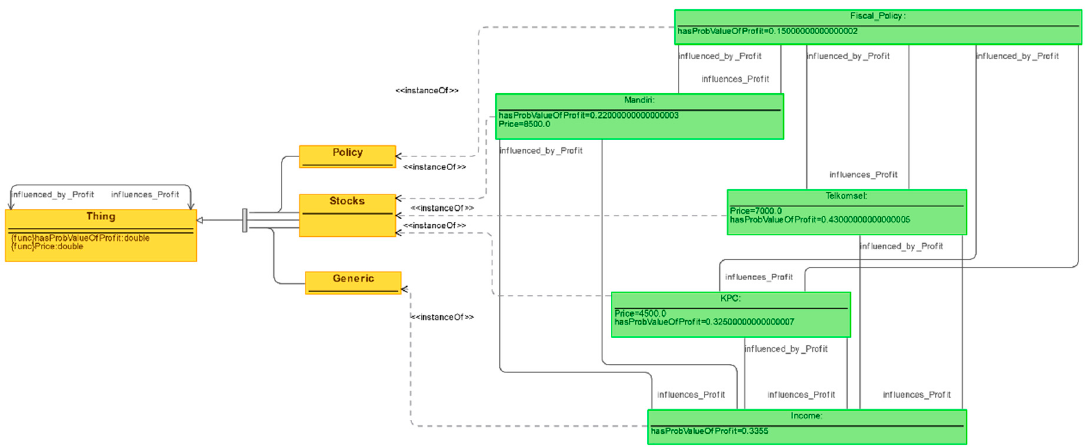
Figure 5. Investment: the result of running the program in the XDSL document.